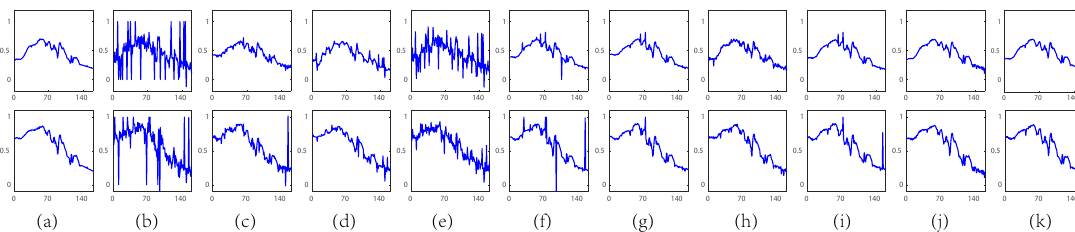
Figure 6. From top to bottom: Spectrum of pixels (55,110) and (110, 184) for the DC Mall HSI dataset. From left to right: ( a ) Original HSI; ( b ) Noisy HSI; ( c ) SVD; ( d ) BM4D; ( e ) TDL; ( f ) WNNM; ( g ) WSNM; ( h ) LRMR; ( i ) LRTV; ( j ) NMoG; ( k ) DP-GMM.